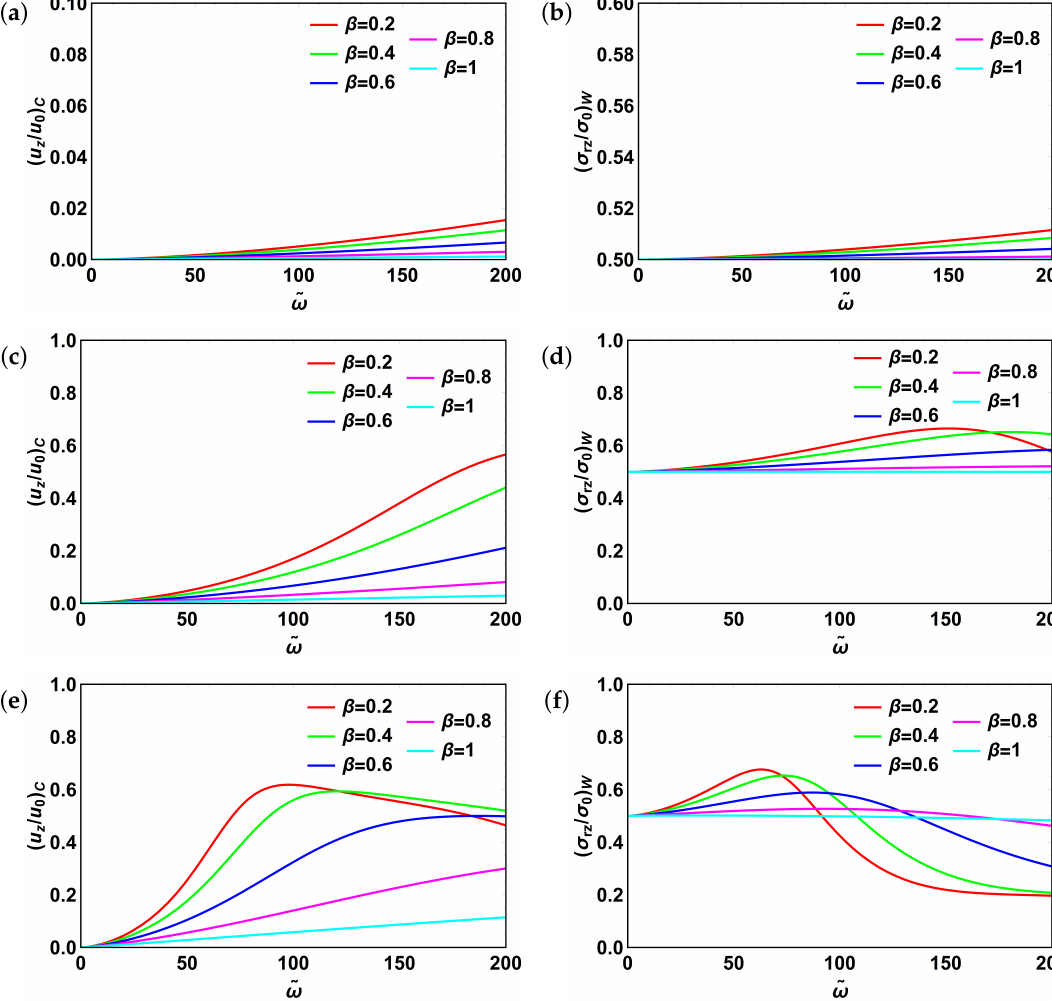
Figure 6. Fractional Kelvin–Voigt model: ( a ) centerline velocity, ˜ a = 0.01; ( b ) shear stress, ˜ a = 0.01; ( c ) centerline velocity, ˜ a = 0.05; ( d ) shear stress, ˜ a = 0.05; ( e ) centerline velocity, ˜ a = 0.1; ( f ) shear stress, ˜ a = 0.1. For all plots α = 0.5. Subscripts “c” and “w” stand for “centerline” and “wall”,